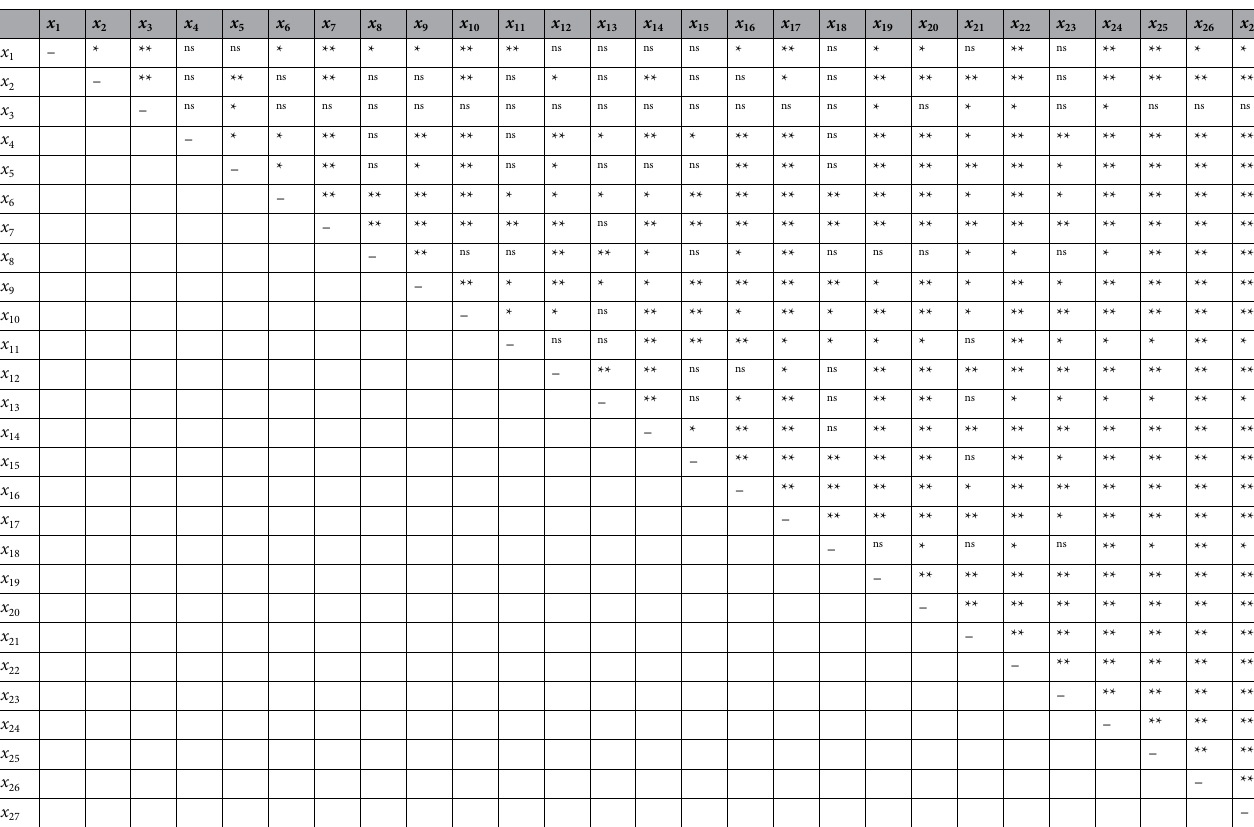
Table 5. Correlation analysis. *Significant at the 0.05 probability level. **Significant at the 0.01 probability level; ns Not significant.